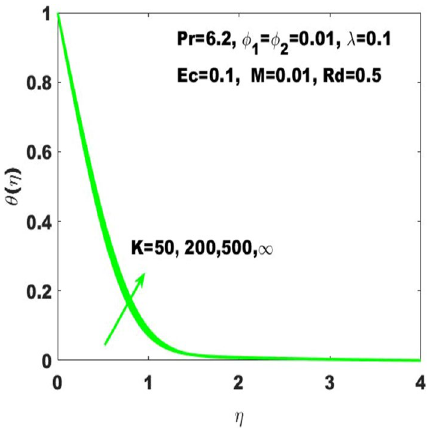
Figure 5. θ ( η ) for diverse values of K.